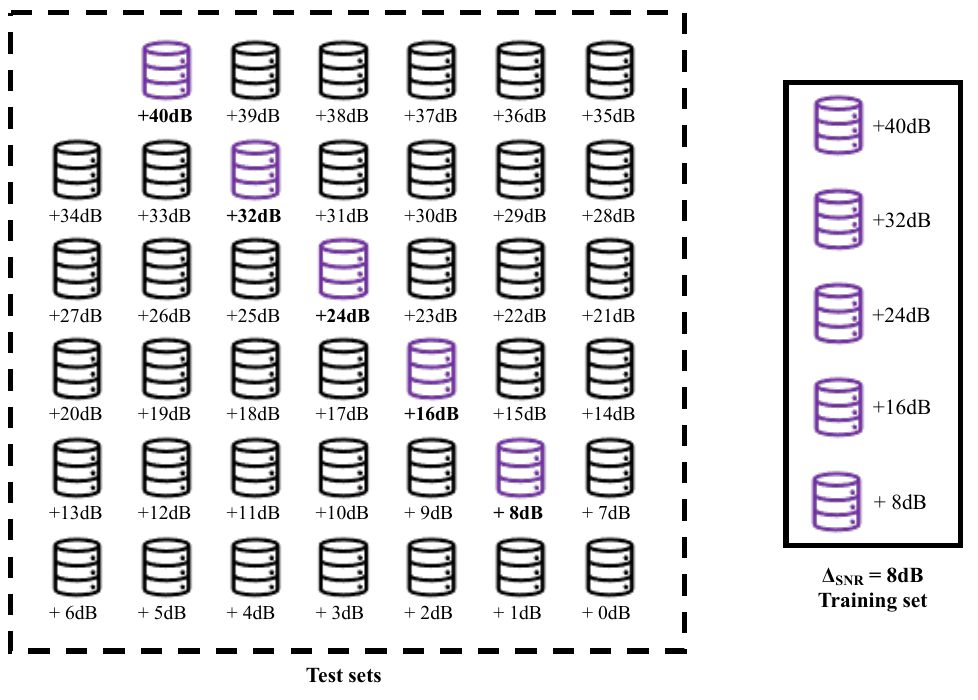
Figure 1. Diagram of the creation of virtual enlarged training set for one scenario using SNR min = 1 dB and SNR max = 40 dB and stepping factor ∆ SNR = 8